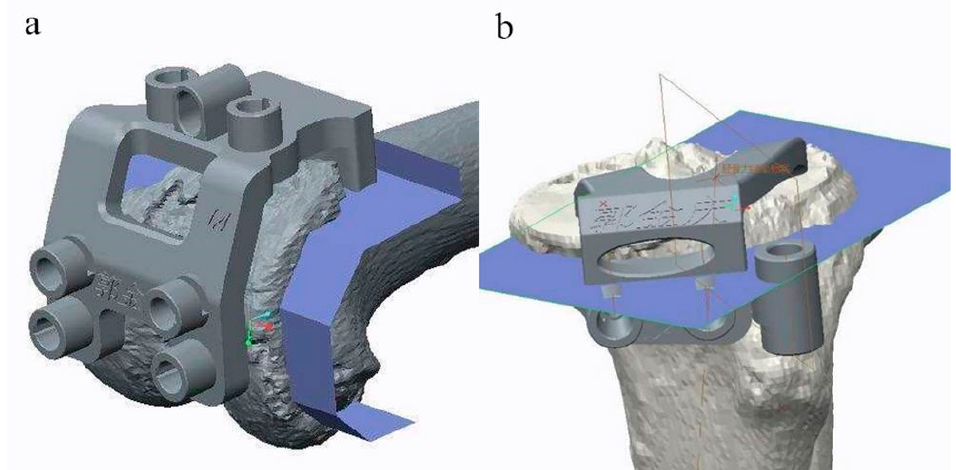
Figure 1. Screenshots of the femoral ( a ) and tibial ( b ) patient-specific instrumentation (PSI) design. Note: The embossed Chinese on the PSI design prototype is the name of the corresponding patient.